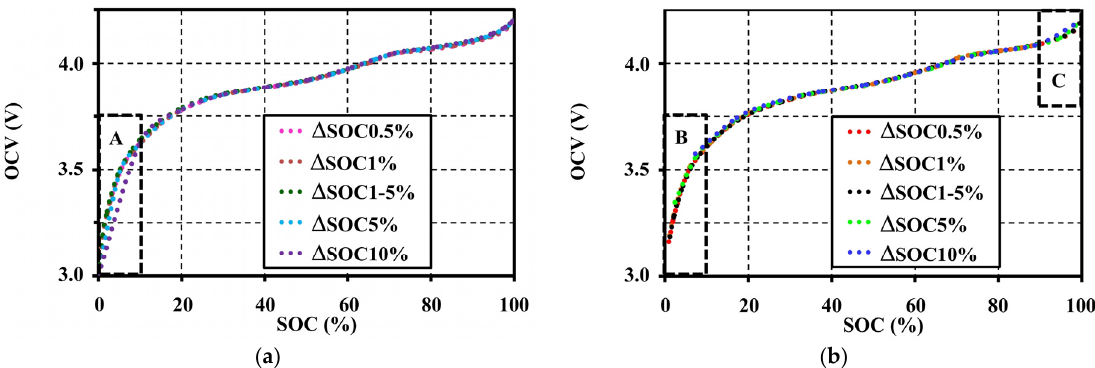
Figure 4. Effects of step-sizes during pulse tests on the OCV characteristic at 20 °C with 10 min resting: ( a ) under the charge test; and ( b ) under the discharge test.